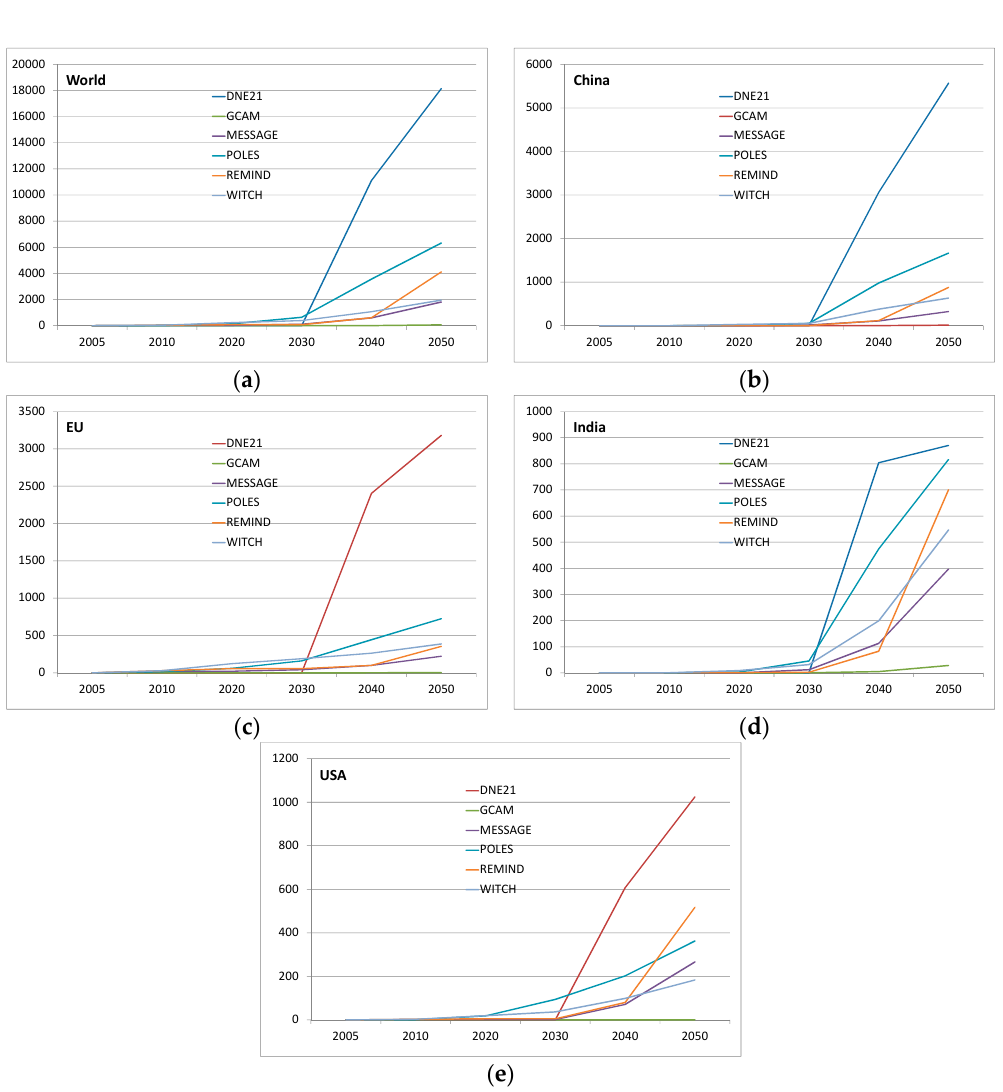
Figure B1. Inter-model comparison of installed capacity (GW) for nuclear in ( a ) World (2030–2050 growth rate = 4%–12% p.a.); ( b ) China (2030–2050 growth rate = 4%–12% p.a.); ( c ) The EU (2030–2050 growth rate = 3%–13% p.a.); ( d ) India (2030–2050 growth rate = 5%–13% p.a.) and ( e ) USA (2030–2050 growth rate = 3%–6% p.a.).